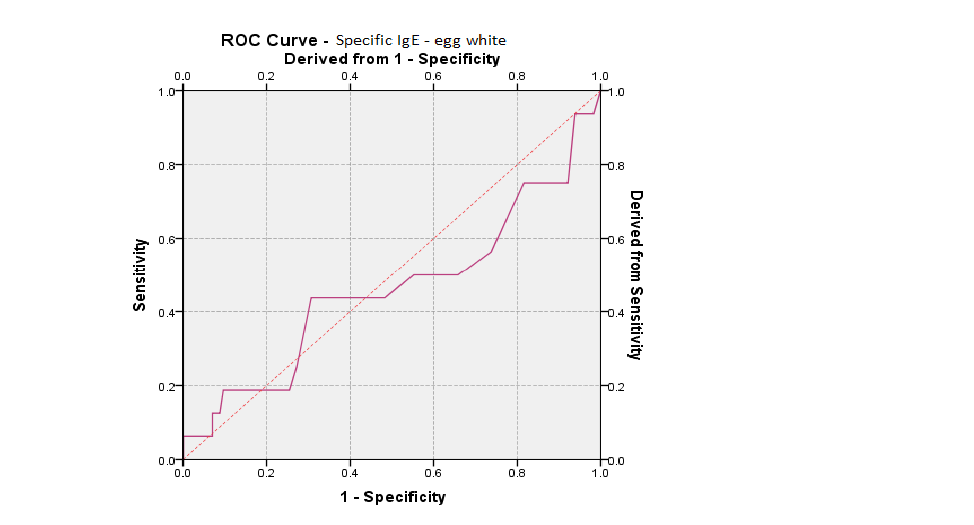
Table 6. Estimated parameters in the analysis of the ROC curve for specific IgE-cow’s milk/disease remission.